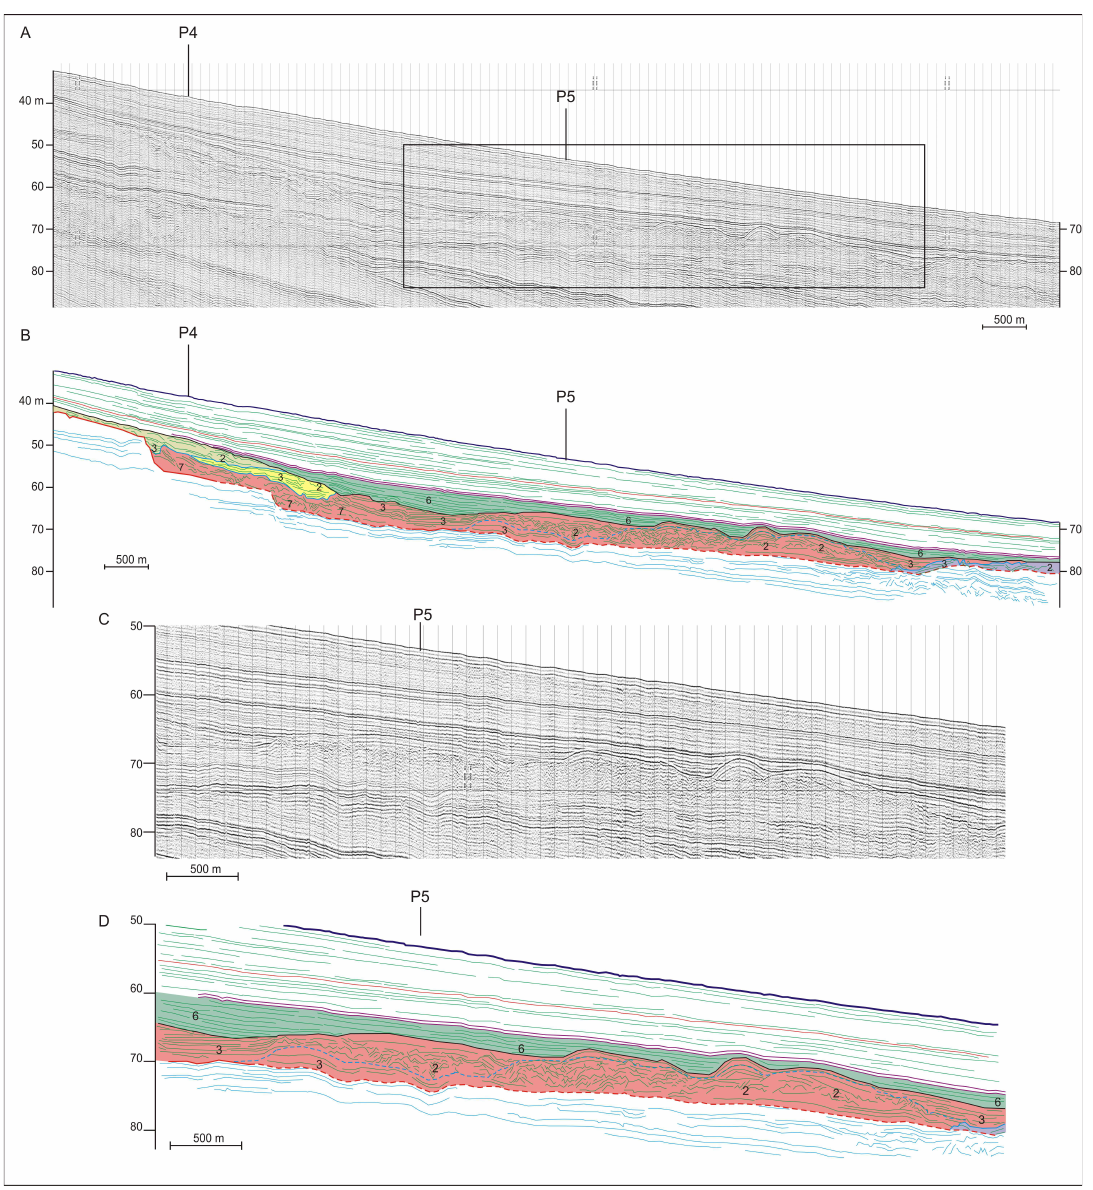
Figure 7. Part of seismic profile T1. Seismic section ( A ) and interpretation ( B ) showing, among others, units B m , C m , and D m . ( C , D ) report an enlargement and its interpretation of the seismic profile sector included in the rectangle reported in ( A ). Note the dune-like / barrier morphologies within unit B m ; the older subunit (B1 m ) is located seaward of the younger subunit (B2 m ), which is wider and arranged in a continuous landward backstepping pattern (retrograded) with respect to the older